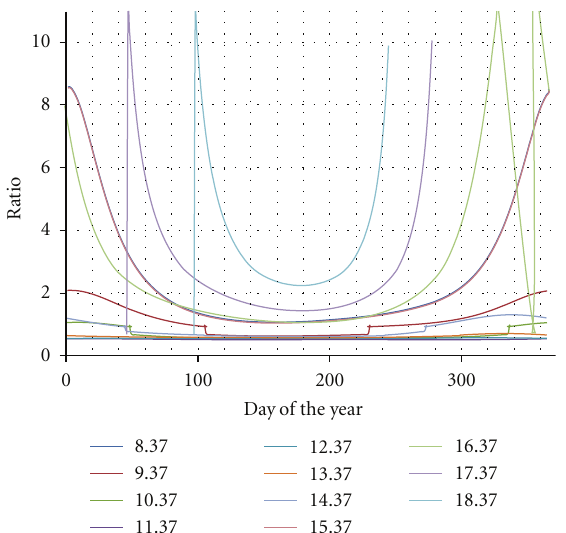
Figure 18: Ratio of mirror 2 along the year (shadows are consid- ered).